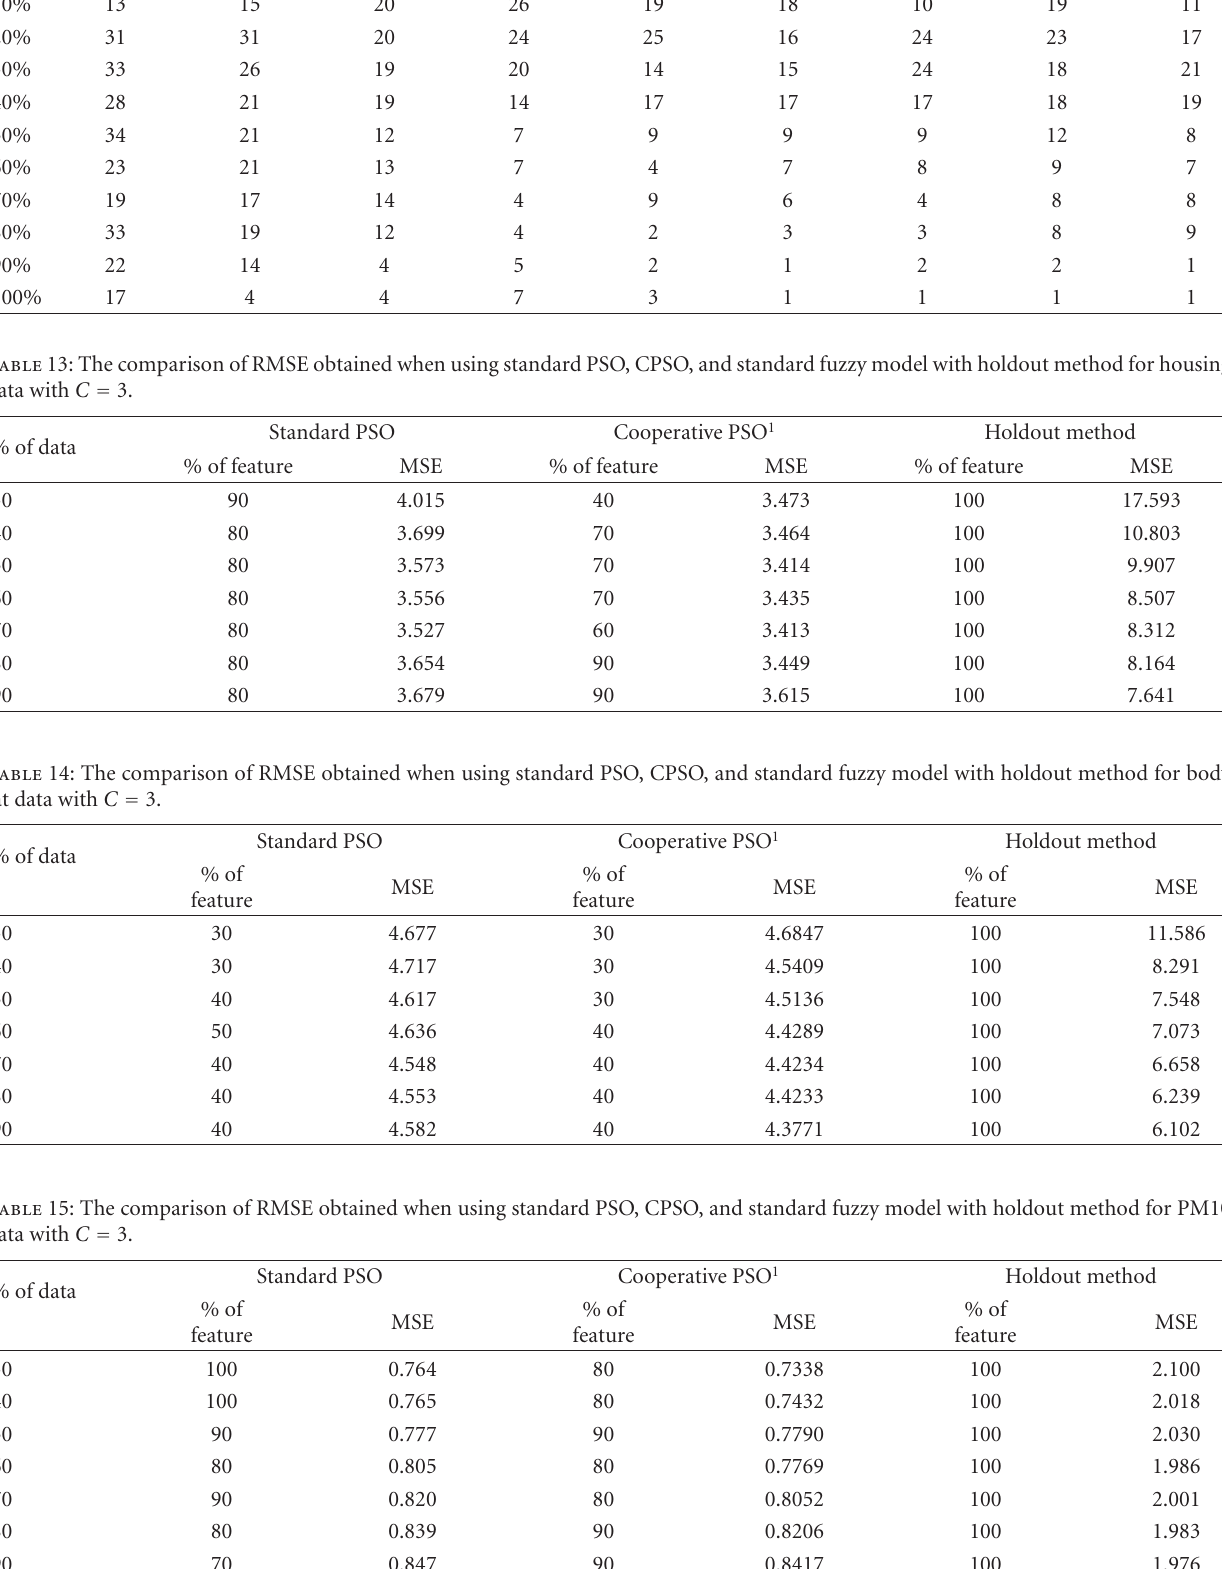
Table 12: Percentage of improvement of the RMSE obtained when using CPSO over the results formed by the PSO; Housing data set. F D = 10%